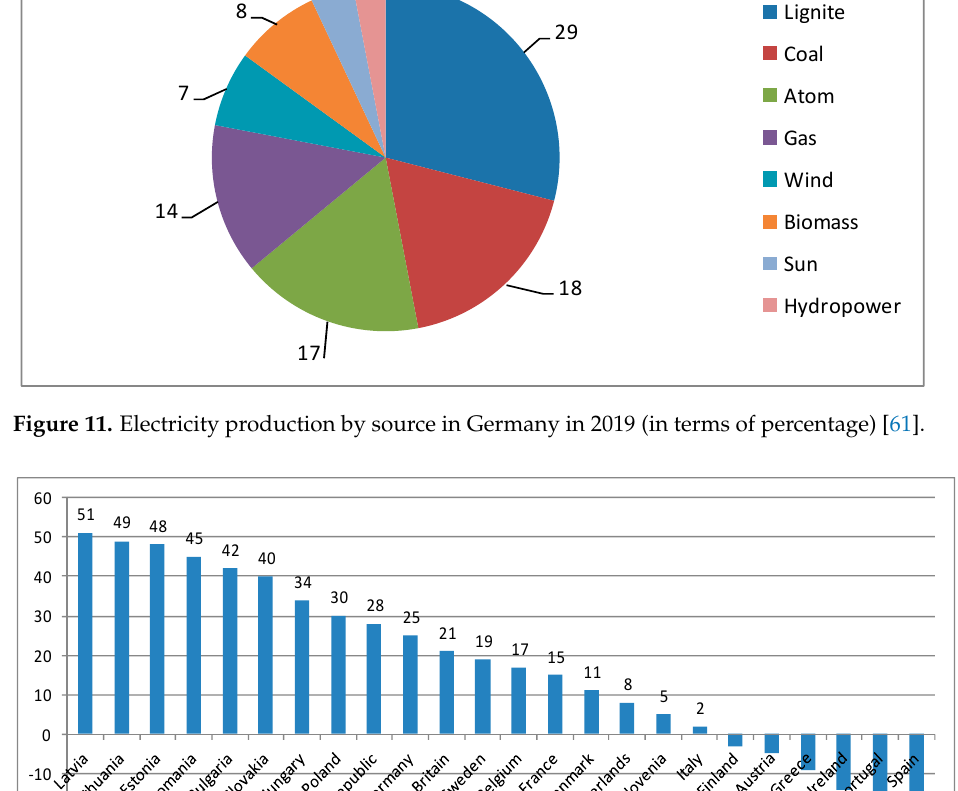
Figure 11. Electricity production by source in Germany in 2019 (in terms of percentage) [61].